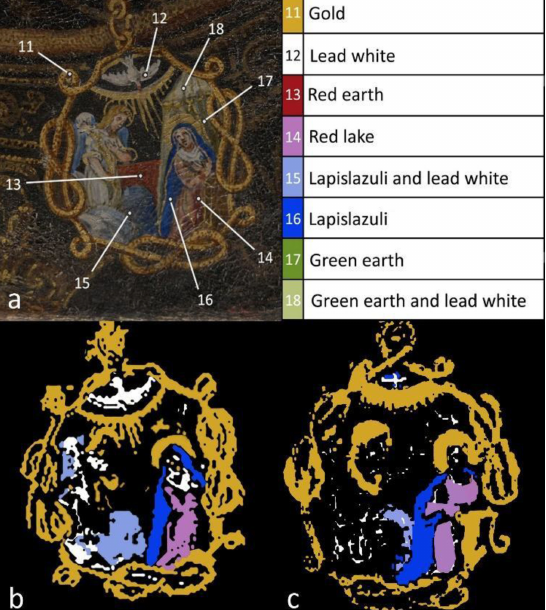
Figure 8. Pendant of the Santissima Annunziata for the Portrait of Carlo Emanuele I: ( a ) map of analyzed points using FORS and XRF spectroscopy, ( b ) result of the SAM algorithm to map similar pigments and pigments mixtures represented in pseudo-colors; ( c ) comparison of pigments distribution with the pendant in the portrait of Emanuele